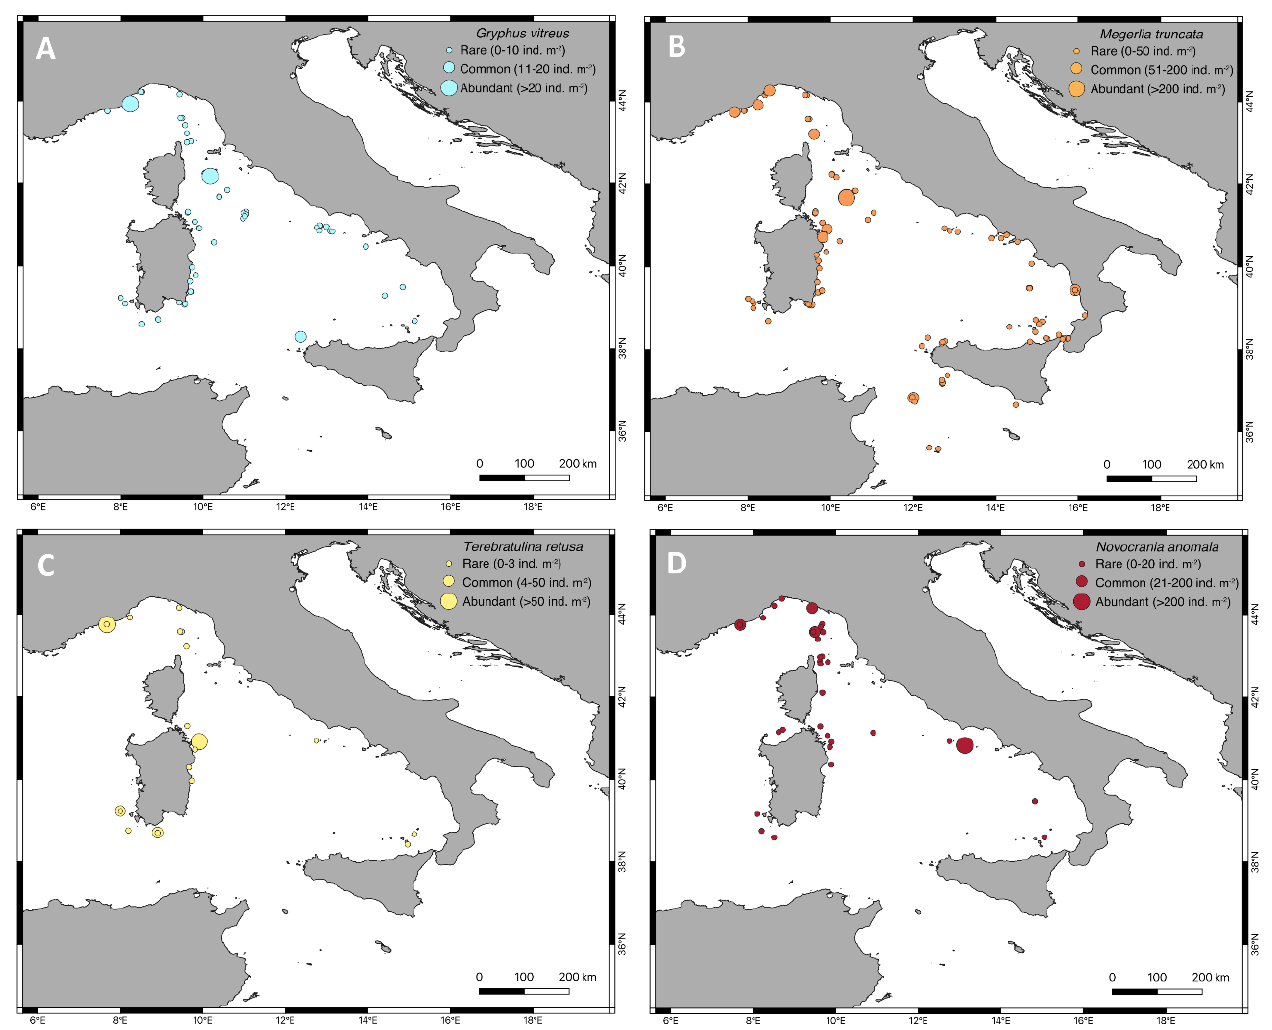
Figure 6. ( A – D ) Distribution maps of the four brachiopod species recorded in this study with an indication of the relative abundance of the populations.